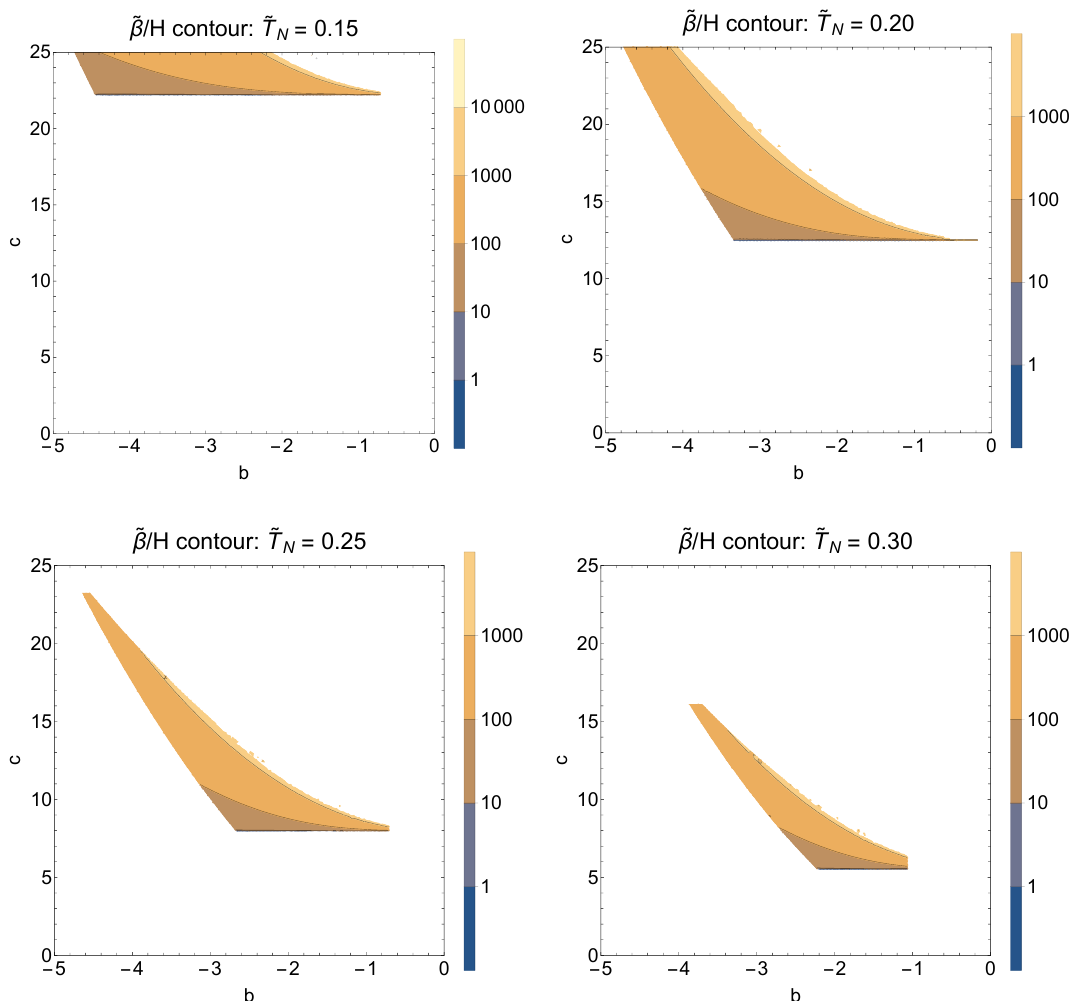
˜ Figure 3. Contours of β/H are shown in the ( b, c ) plane for the allowed parameter space for lower values of ˜ T : ˜ T = 0 . 15 (upper left), 0 . 20 (upper right), 0 . 25 (lower left), and 0 . 30 (lower N N right). The contours also satisfy the conditions: c ≥ b 2 , c ˜ T ˜ ˜ ˜ ˜ β/H ≥ S E / 140 T N and ξ ≥ 0